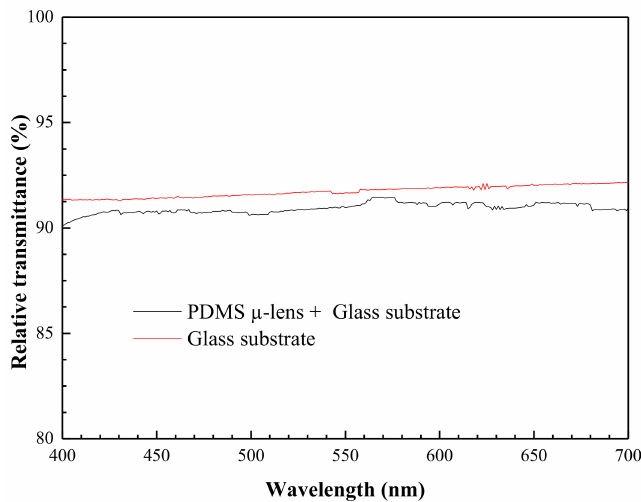
Figure 6. Relative transmittance of the glass substrate and the PDMS µ -lens plus the glass substrate for the 400 to 700 nm wavelength range.